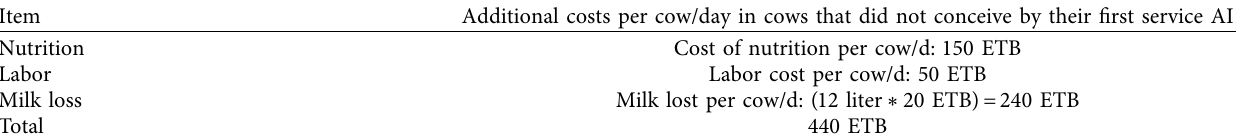
Table 3: Additional expenses for management procedures in cows that failed to conceive at their first AI, incurred due to a larger number of days